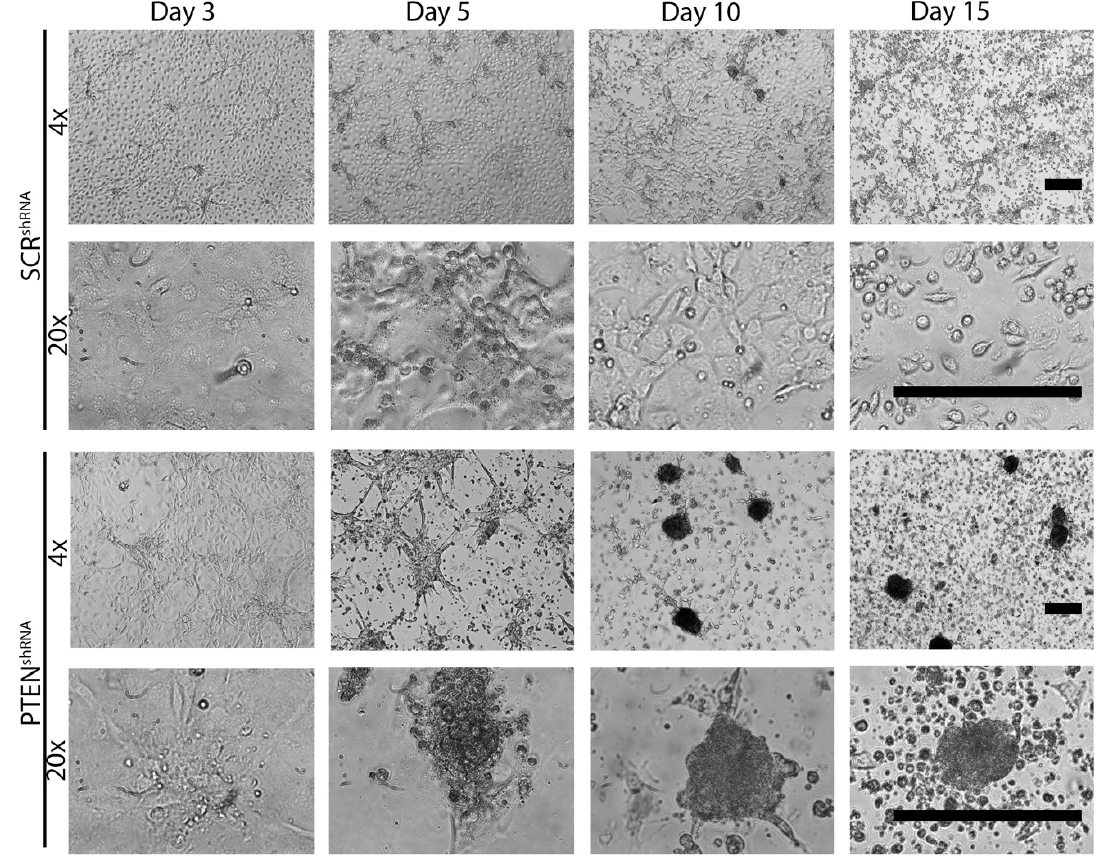
Figure 2. Overgrowth of fallopian tube epithelia (FTE) cells lacking PTEN results in budding of MTS-like structures. Representative images of MOE SCR shRNA (top) and MOE PTEN shRNA (bottom) of monolayers and structures formed over 15 days of growth. Scale bar = 250 μ m. n = 4.